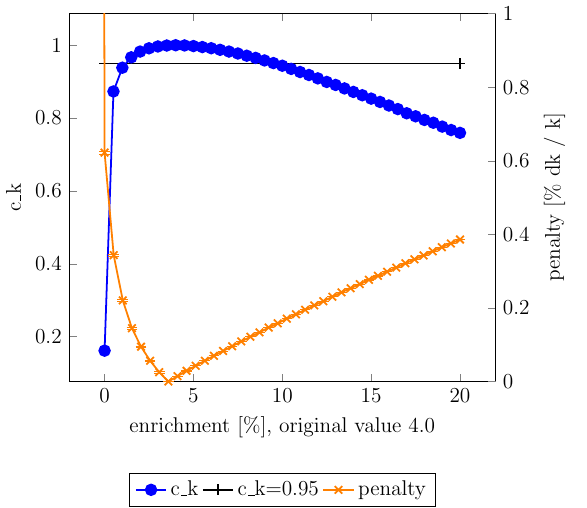
Figure 4. Evaluation of similarity between systems with different amount of H